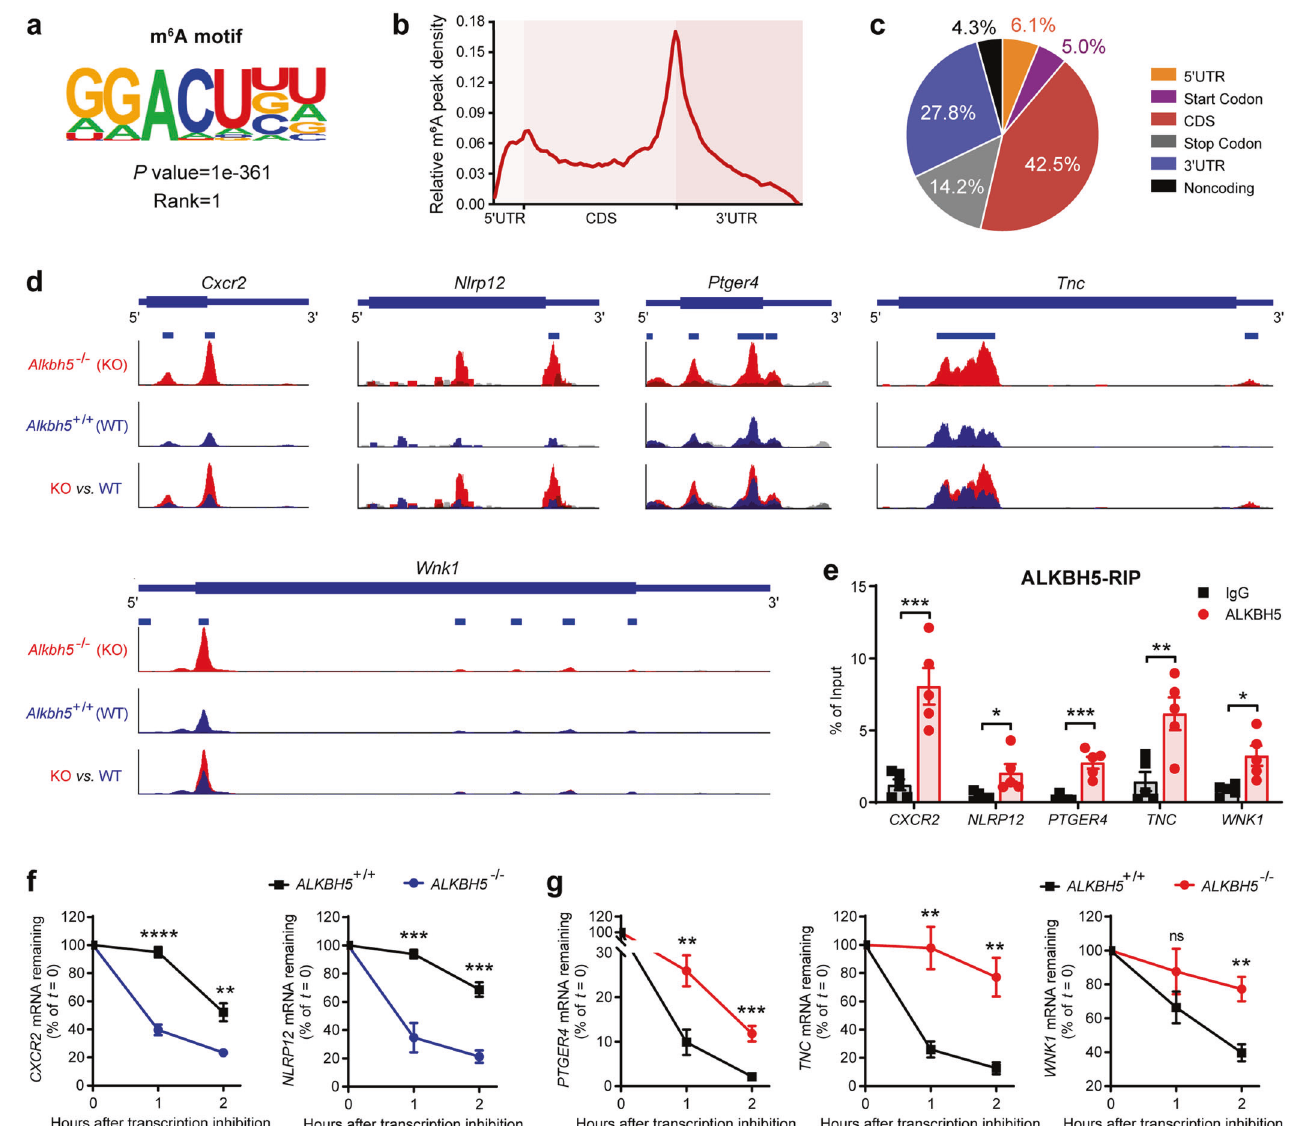
independent biological replicates. b Metagene pro fi les of m 6 A peak density along a normalized transcript as in a . CDS, protein coding sequence; 3 ′ UTR, 3 ′ untranslated region. c The distribution of m 6 A peak in the indicated transcript segments as in a . d m 6 A abundance on indicated mRNAs from our m 6 A-seq data (GSE127732). Red, Alkbh5 – / – IP; blue, Alkbh5 + / + IP; gray, input. The y axis represents the normalized m 6 A signal along the gene. Two independent biological replicates. e . RIP-qPCR analysis of ALKBH5 binding to indicated mRNAs in dHL-60 human neutrophils infected with E.coli ( n = 5). f , g mRNA degradation of indicated targets in WT ( ALKBH5 + / + ) and ALKBH5 -de fi cient ( ALKBH5 – / – ) dHL-60 human neutrophils treated with actinomycin D for the indicated times ( n = 5). Data were normalized to 18S rRNA expression and the residual mRNAs were normalized to t = 0 h. All data are mean ± SEM of biologically independent samples. * P < 0.05; ** P < 0.01; *** P < 0.001; **** P < 0.0001; ns not signi fi cant. Two-tailed unpaired Student ’ s t test ( e – g